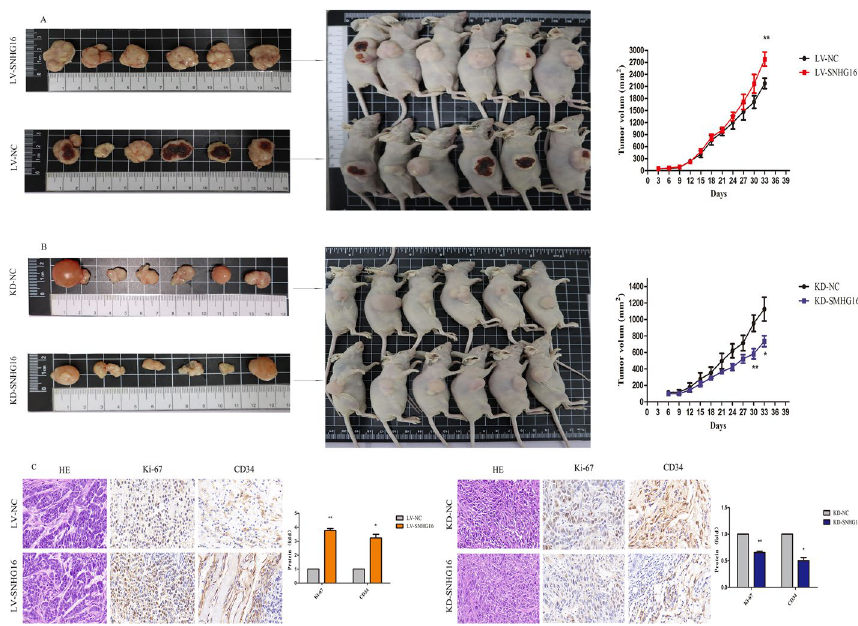
Fig. 3 The effect of SNHG16 on ESCC cell tumourigenesis in vivo. Images of the xenograft model in BALB/c nude mice from four treatment groups ( n 6 for each group) on day 35. A Images of mice and tumour = volumes of LV-SNHG16 and the control group (LV-NC). B Tumour volumes and growth curve of KD-SNHG16 and the control group (KD-NC). C Tumour sections under HE staining and IHC staining for Ki-67 and CD34. Scale bar, 100 μm. Data are listed as the mean SD of three independent experiments. * P < 0.05, ** P < 0.01, ± *** P <